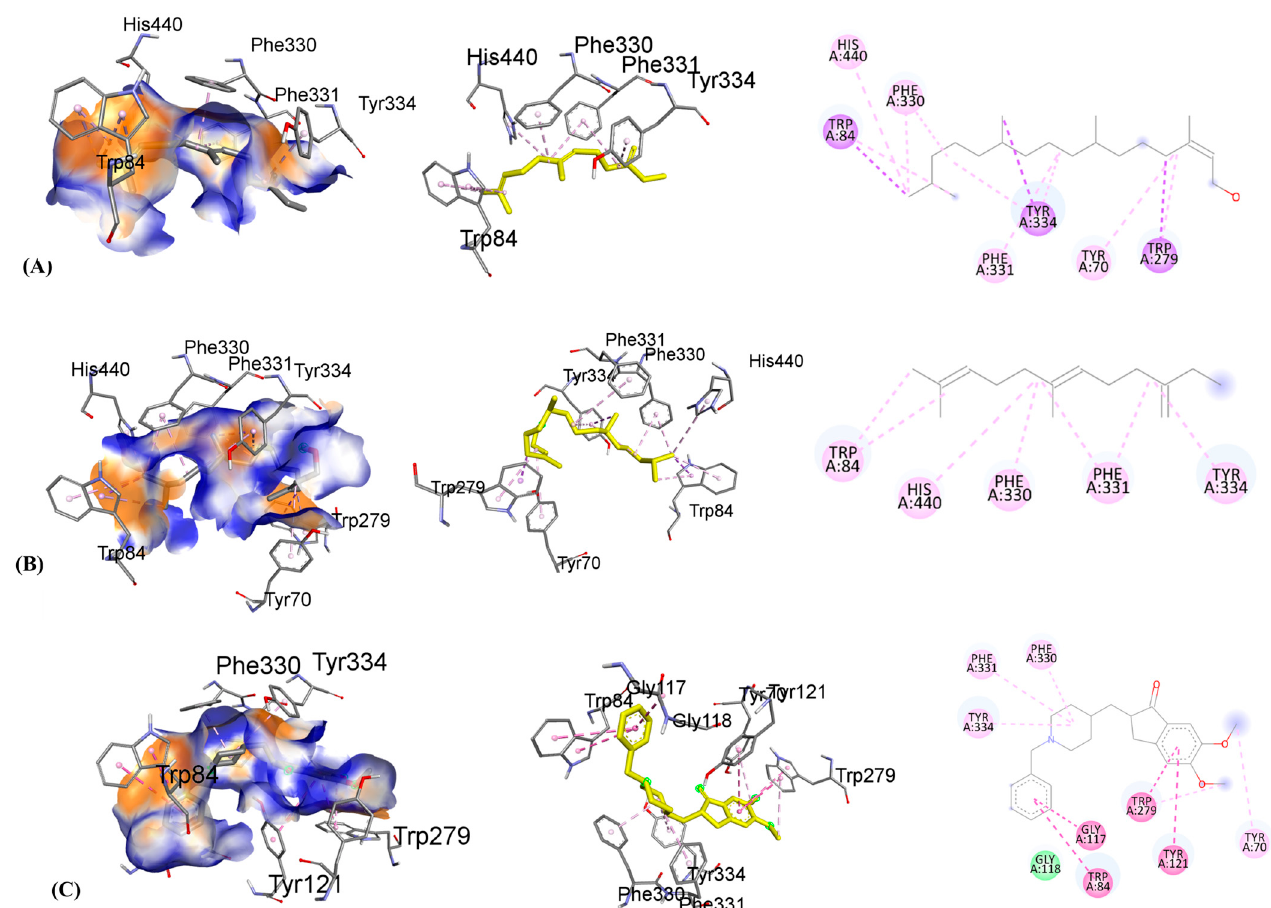
Figure 13. The binding mode with hydrogen acceptance (blue) and hydrogen donor (orange) surface (leftmost), with 3D interaction having drug in yellow color (middle) and with 2D binding interactions (rightmost) ( A ) beta-farnesene, ( B ) phytol, and ( C ) donepezil using target acetylcholinesterase protein 1GQR. The green color indicates hydrogen bonding, whereas the dark purple color is indicating hydrophobic interactions and the light purple color is showing the electrostatic binding linkages .